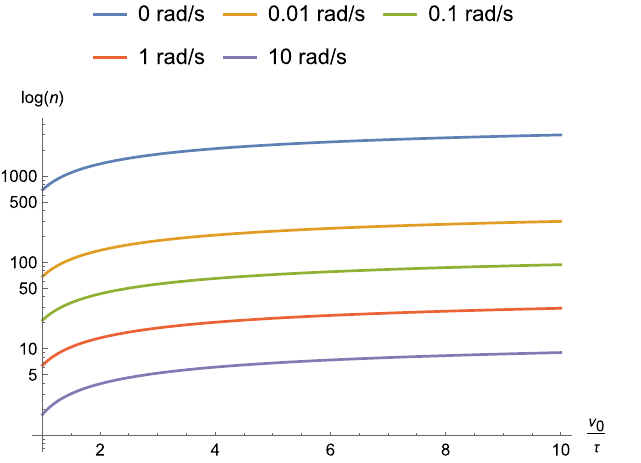
Figure 13. Dependence of length n on ν 0 /τ at different frequencies for parameters that approximate an axon ( α = 10 − 6 , R = 10 12 � , C = 10 − 8 F , and ν 0 ( t ) = 100 mV